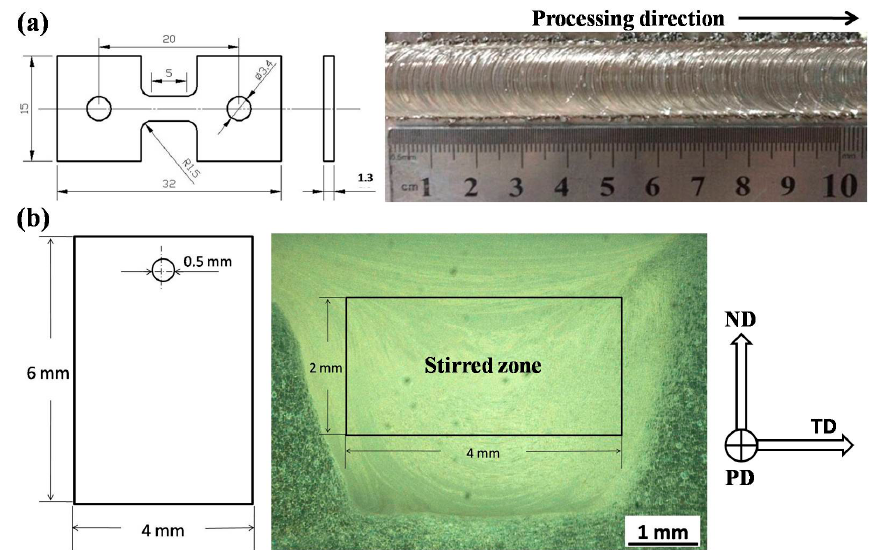
Figure 17. ( a ) Schematic diagram of tensile specimen and the surface appearance of processed region; and ( b ) schematic diagram of immersion specimen and the cross-section macrograph of the FSP specimen.